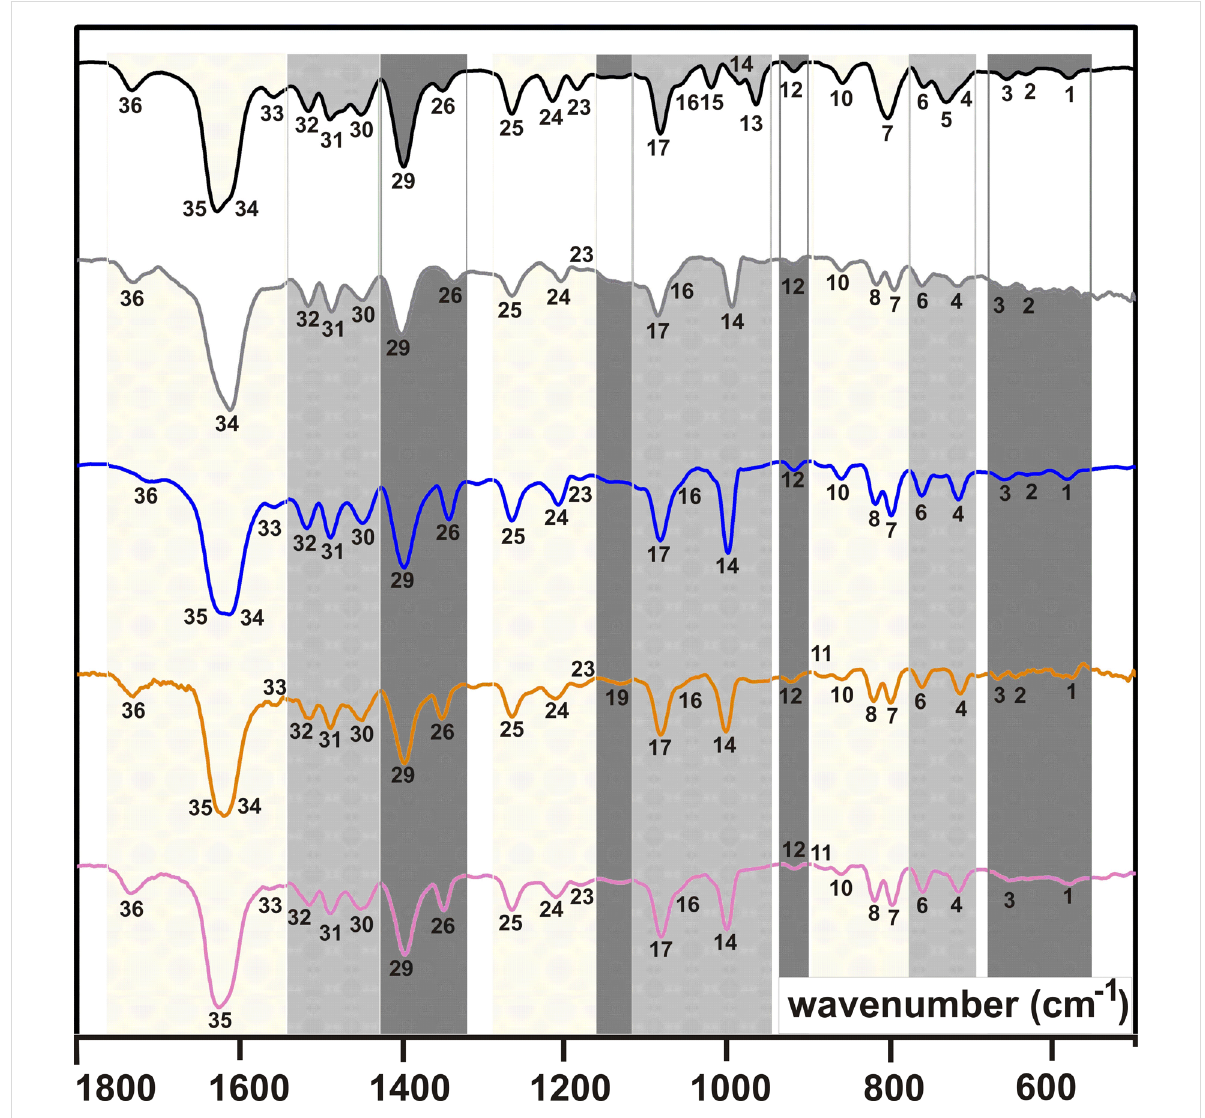
Figure 2: IR spectra (KBr) in the range of 500–1800 cm − 1 for H 2 TPP(CONMe 2 ) 4 ( 2 , top) and MTPP(CONMe 2 ) 4 (M II = Zn, 2a (gray); Cu, 2b (blue); Ni, 2c (orange); Co, 2d (purple)).